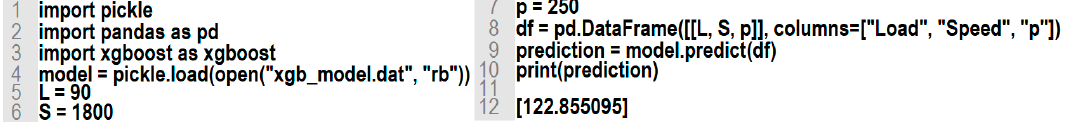
Figure 10. The eXtended Gradient Boosting Regressor (XGBRegressor) training of the gblinear model. The model was run (in the test phase) as described in Figure 11 by “reading the boost” (“rb”) model that was “written” (“wb”) in the training phase.